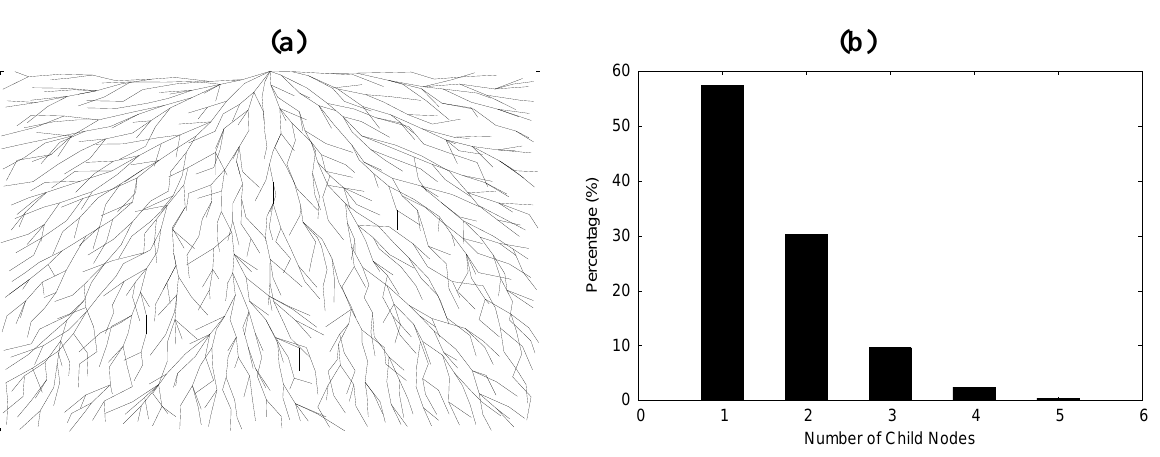
Figure 2. Tree topology of a sensor network. (a) a tree with considering branch identifier. (b) percentage of the number of child node at each parent